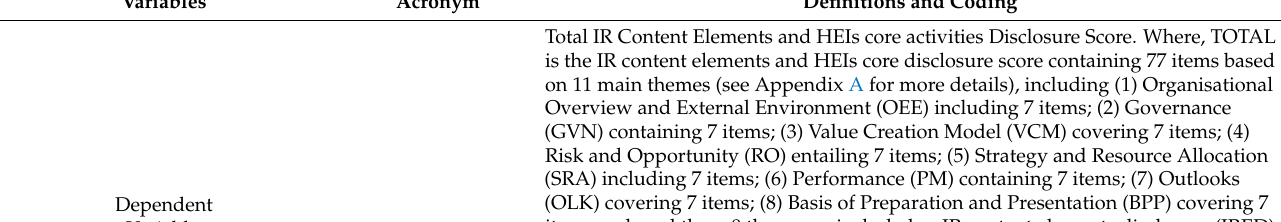
League Table Position Ranking: Measured by performance Position Ranking in Complete University Guide League